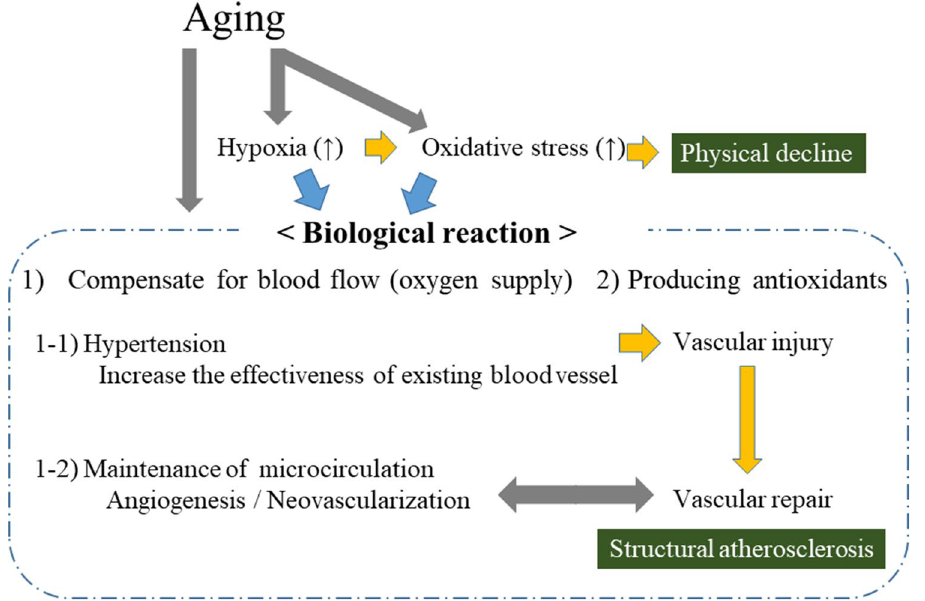
Figure 7. Potential biological reaction for hypoxia and oxidative